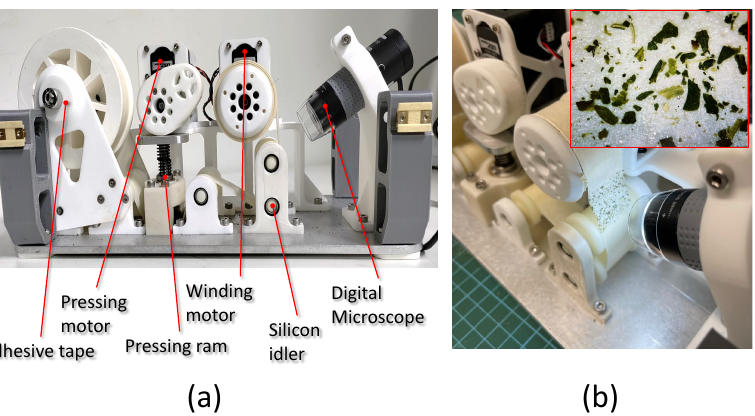
Figure 4. The sample audit sensor with major components ( a ) and the extracted dirt particles under the view of the microscope (the 10 × magnified image captured in the inset) ( b